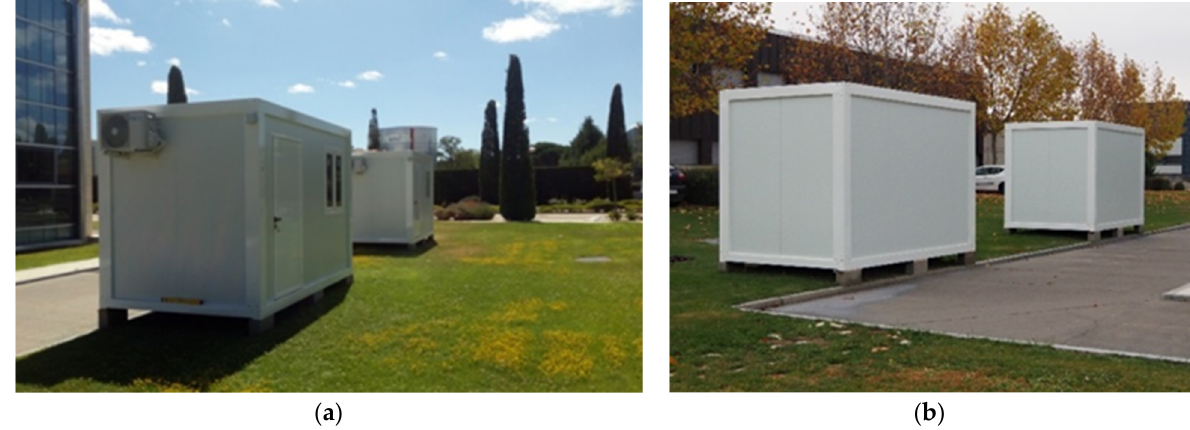
Figure 1 . Test cells used for the demonstration of the PCM solutions: ( a ) South-West view; ( b ) North-East view.